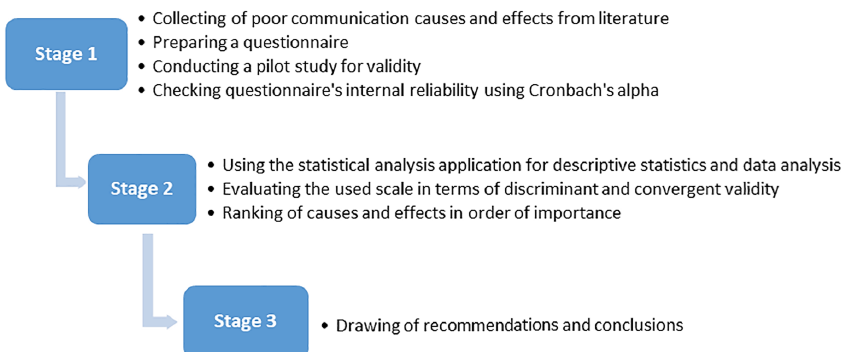
Figure 1. Methodology of the